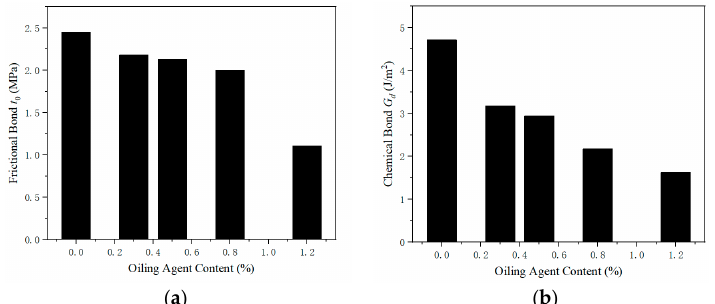
Figure 14. Effect of the fiber oil content on the bond performance of the matrix [43]. ( a ) Frictional